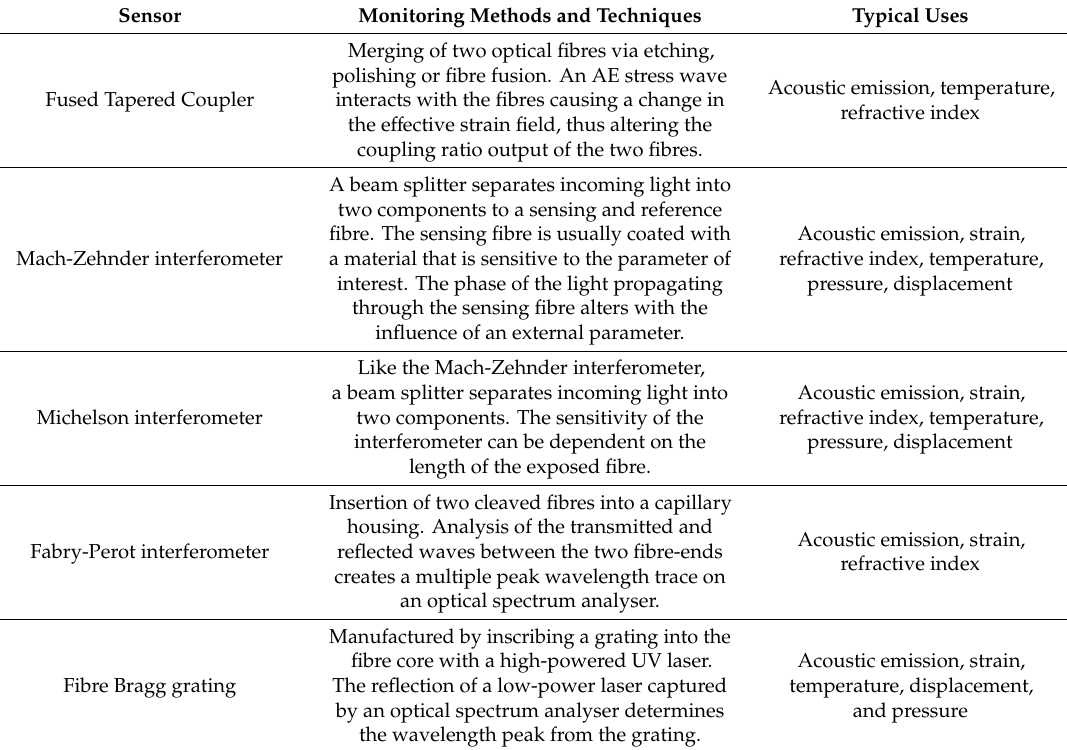
Table 1. An overview of the types of sensors discussed in this review.